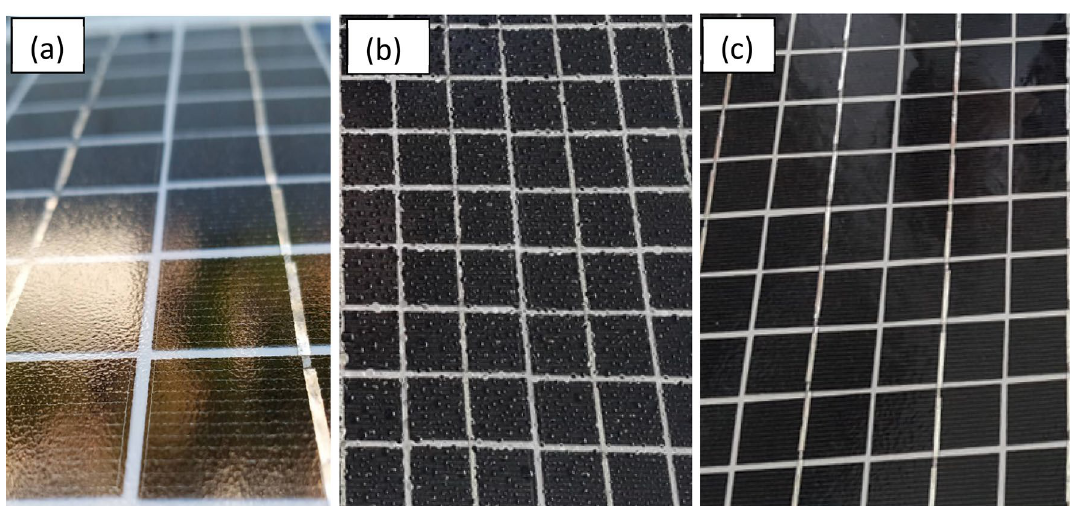
Figure 11. ( a ) Uncoated surface of PV panels ( b ) and ( c ) surface of uncoated and coated PV panels, respectively, after water